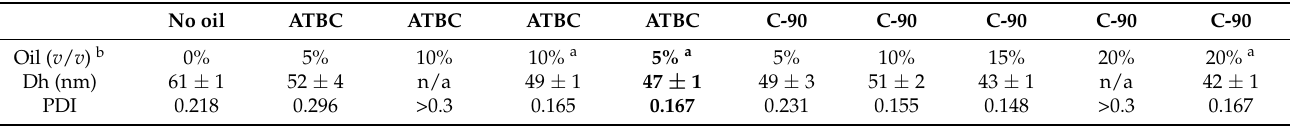
Table 1. Emulsion optimization assay. Droplet Dh according to the oil ratio and type (average of three replicates, intensity-weighted